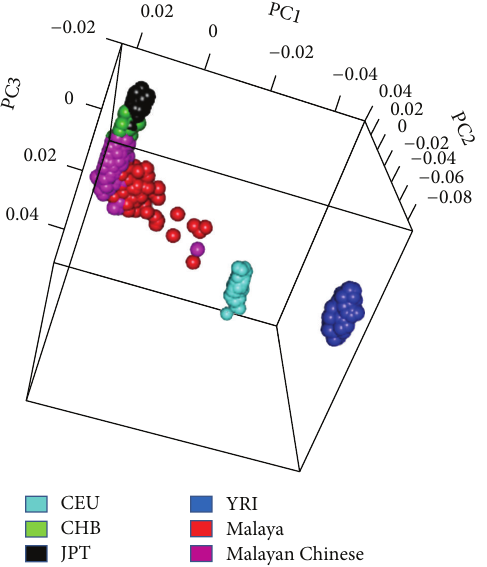
Figure 1: Principal components analysis of Chinese and Malay cohorts. Notably the Malaysian Chinese were a more homogeneous population than the Malays (CEU: North Europeans from CEPH; CHB: Beijing Chinese; JPT: Japanese; YRI: Yorubans from